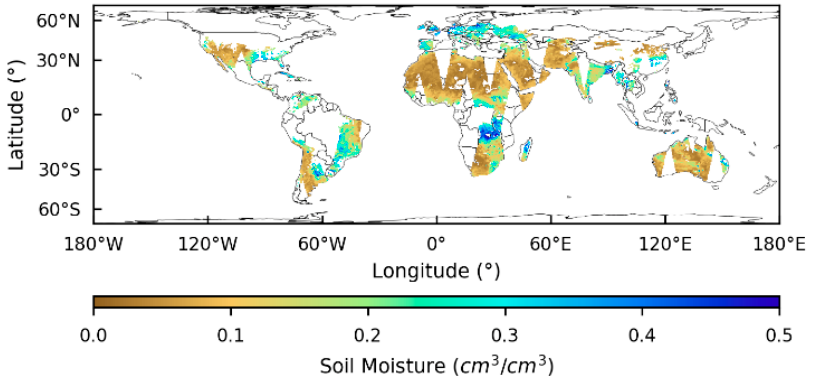
Figure 1. Averaged SMAP Level-3 soil moisture from satellite descending passes and ascending passes on 1 January 2018.